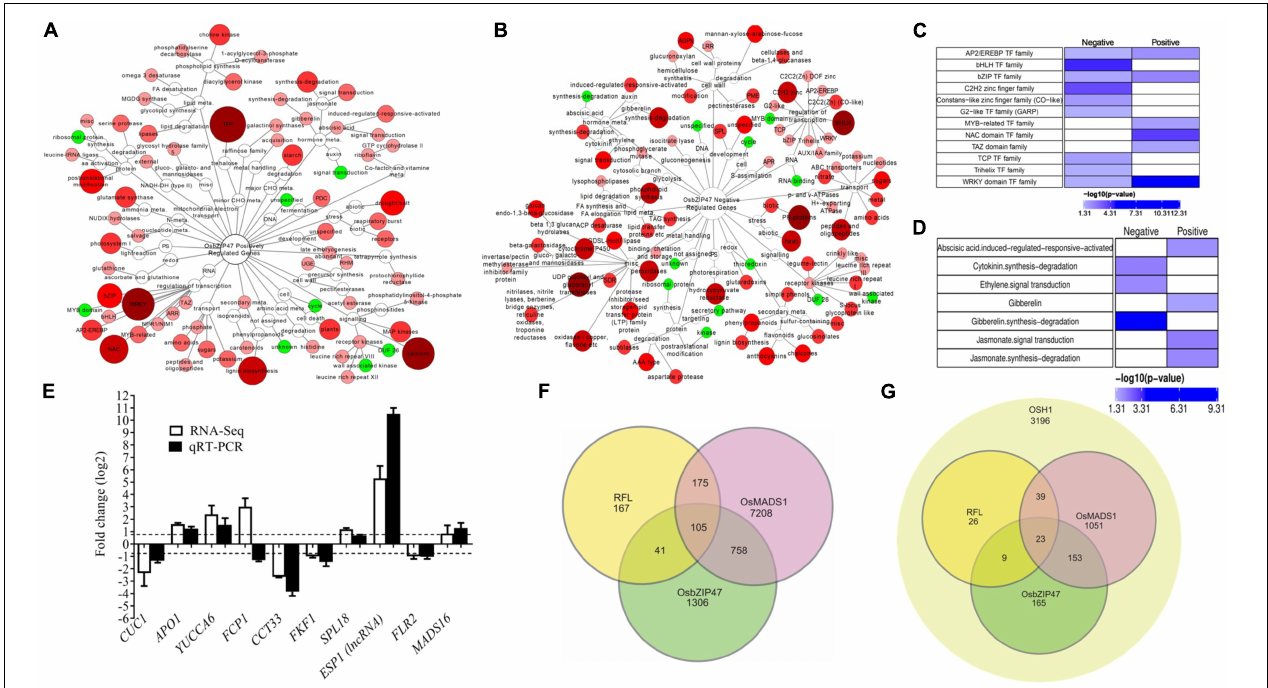
FIGURE 6 | Differentially expressed genes (DEGs) and GO enrichment analysis of pathways downstream to OsbZIP47. Enrichment networks depicting pathways regulated by OsbZIP47. (A) positively regulated, and (B) negatively regulated pathways. The red and green color nodes represent enriched and depleted functional categories, respectively ( P < 0.05). The size and color intensity of the node correlates with the over-representation of genes within the given class. (C) Enrichment map of transcription factor (TF) genes shows those encoding members from bHLH, G2-like, C2H2 zinc finger, TCP, Trihelix are underrepresented, whereas TFs, such as AP2/EREBP, MYB-related, NAC domain, TAZ, WRKY, and bZIP were overrepresented. (D) The 2,210 DEGs annotated in MSU-TIGR v7 were taken for GO-enrichment analysis for phytohormone metabolism and signaling. Cytokinin (CK) degradation, ethylene signal transduction genes, and gibberellin (GA)-synthesis-degradation were enriched in negatively regulated dataset, whereas, abscisic acid (ABA), GA pathway, and jasmonate (JA) pathways predominate in the positively regulated set. (E) RT-qPCR analysis of the relative fold-change for transcripts from several candidate target genes of OsZIP47 in 0.1 to 0.5 cm panicles from OsbZIP47KD as compared to WT tissues. The normalization of transcript level of each gene was done using UBQ5 transcript levels. Error bars represent the standard deviation. (F) Venn diagram showing unique and overlapping sets of differentially expressed genes (DEGs) derived from OsMADS1, OsbZIP47, and RFL transcriptome datasets (Rao et al., 2008; Khanday et al., 2013; this study). (G) Genes implicated to be coregulated by OsMADS1, OsbZIP47, and RFL and bound by OSH1 (Rao et al., 2008; Khanday et al., 2013; Tsuda et al., 2014; this